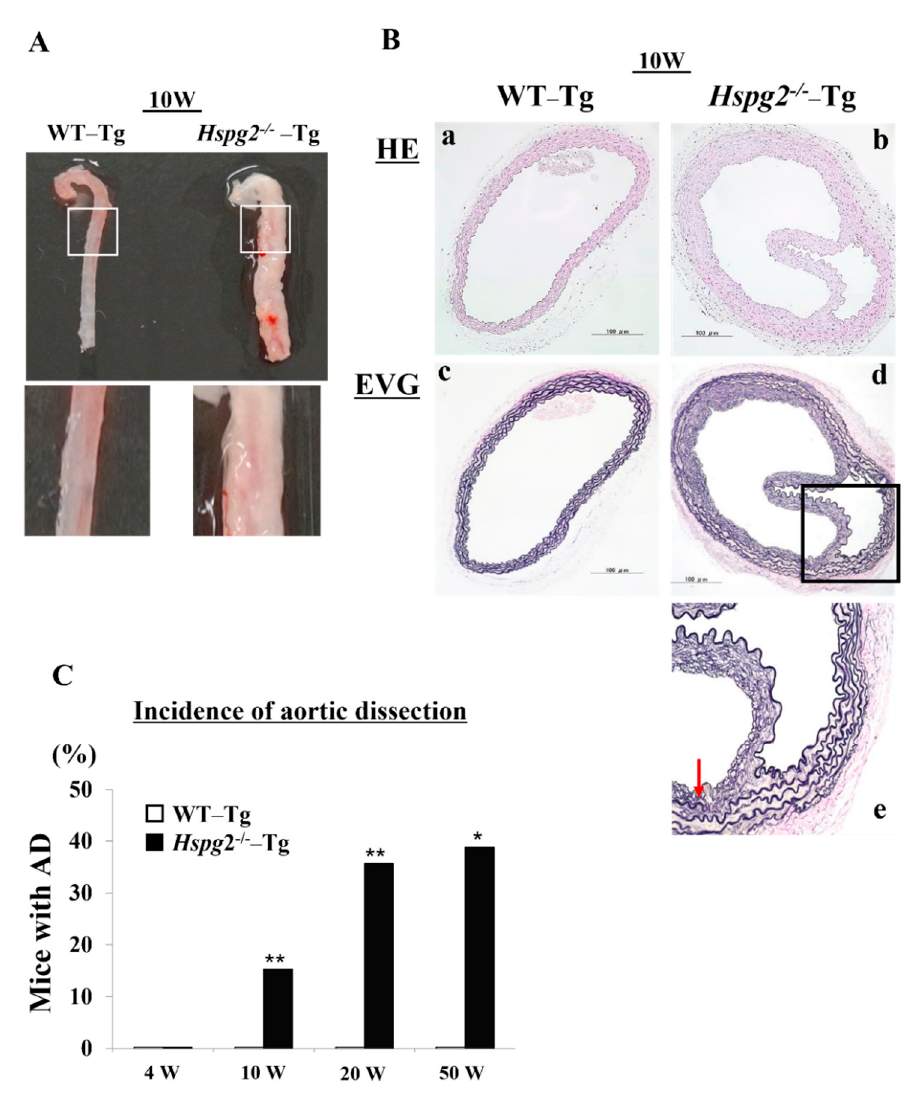
Figure 1. Hspg2 − / − -Tg mice frequently had an aortic dissection (AD). ( A ) Representative image of thoracic AD in Hspg2 − / − -Tg mice at 10 weeks of age, with a possibility that it may occur to whole or part of the thoracic aortic tissue. ( B ) Representative image of hematoxylin/eosin (HE) staining ( a , b ) and Elastica van Gieson (EVG) staining ( c – e ) indicating the tear of elastic lamina of the medial wall (red arrow) (Scale bar = 100 µm). ( C ) Hspg2 − / − -Tg mice had AD with a frequency of about 15.4% at 10 weeks of age (6/39), 35.8% at 20 weeks of age (5/16), and 38.9% at 50 weeks of age (7/18). (Fisher’s exact test, * p < 0.05, ** p < 0.01 vs. WT-Tg). Histological and morphological analyses of aortic tissue in Hspg2 − / − -Tg mice at 1 weeks and 4 weeks of age are shown in supplementary Figure S1.